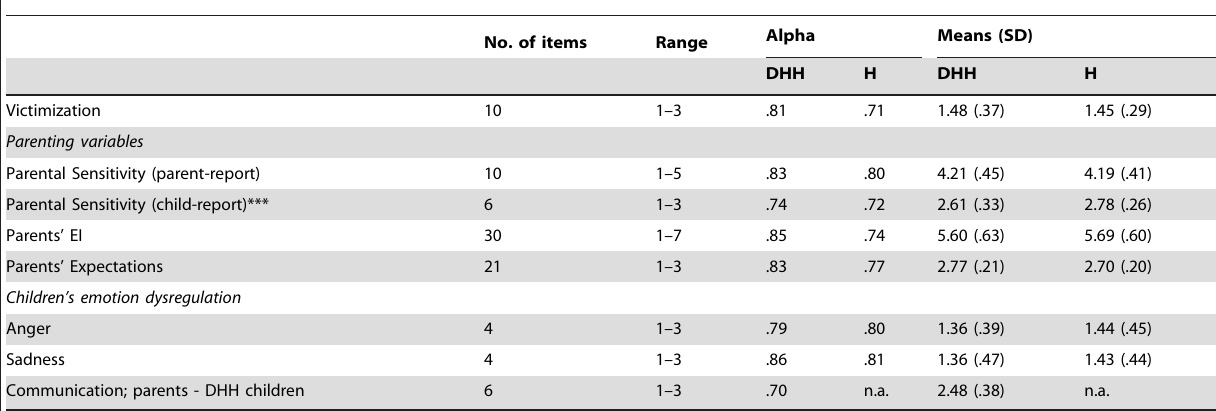
Table 3. Psychometric Properties of